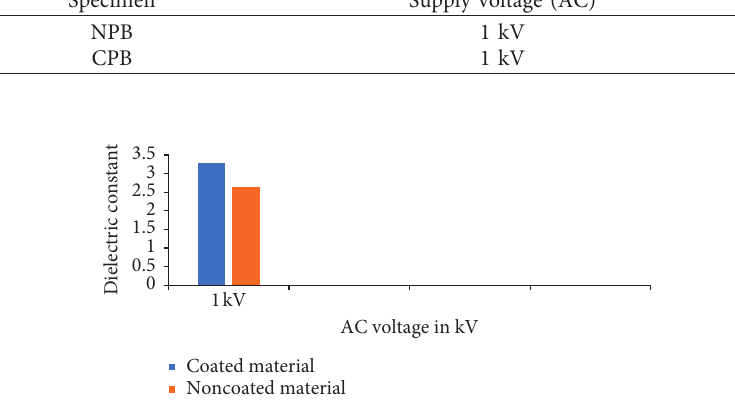
Figure 12: Tan Delta of specimens (NPB and CPB) vs supply voltage. Table 3: Volume resistivity of specimens (NPB and CPB). S. No. Specimen